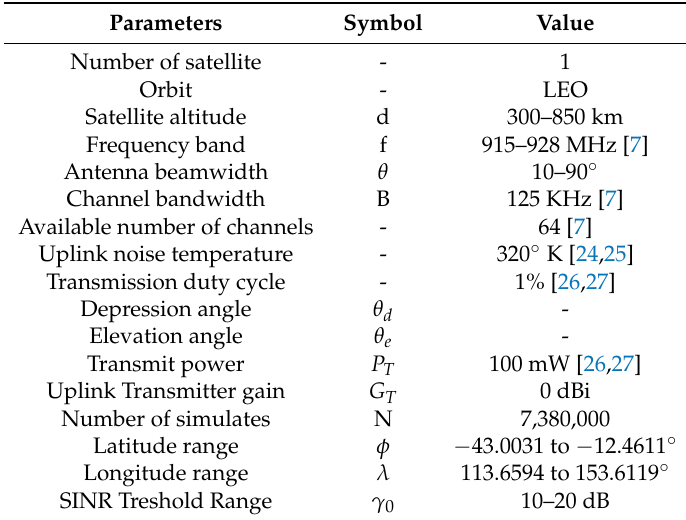
Figure 1. A block diagram for the proposed performance evaluation model of IoT-over-Satellite access system. Table 3. Evaluation